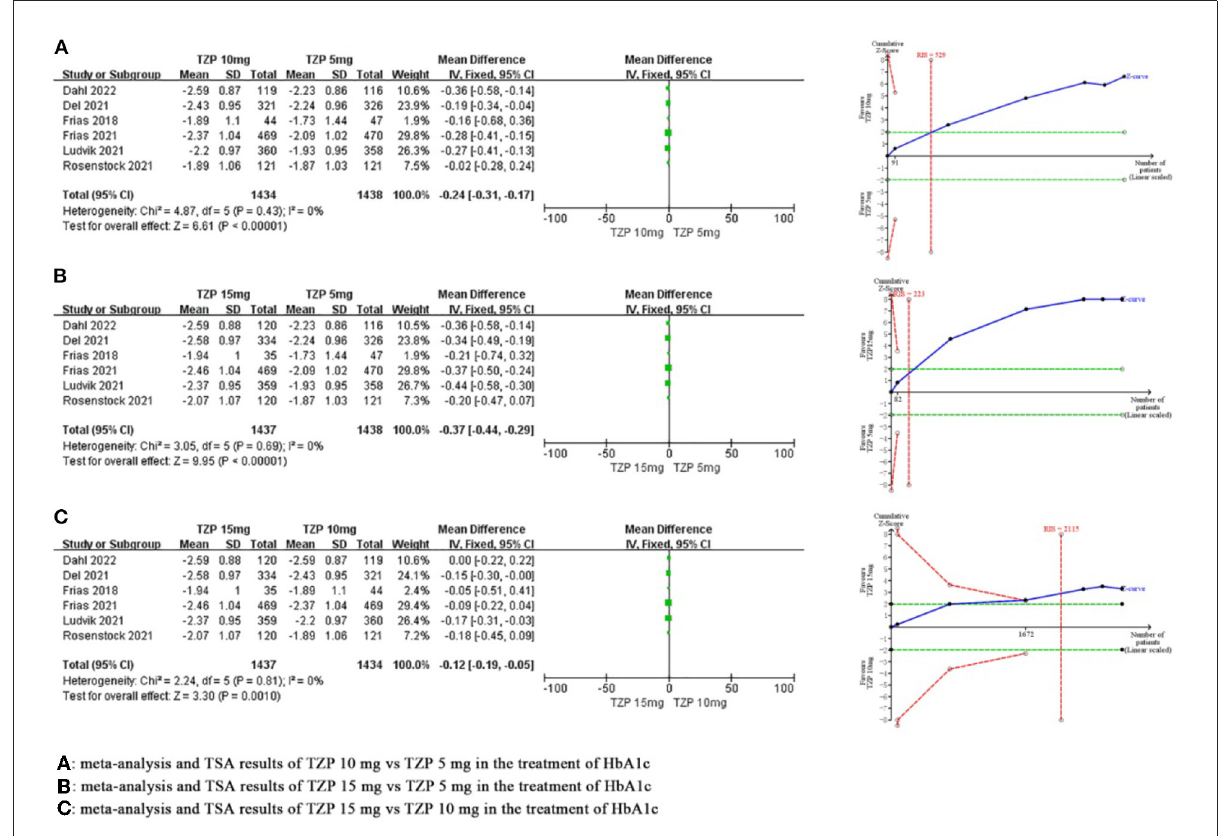
FIGURE3 Meta-analysis and TSA results of different doses of TZP for